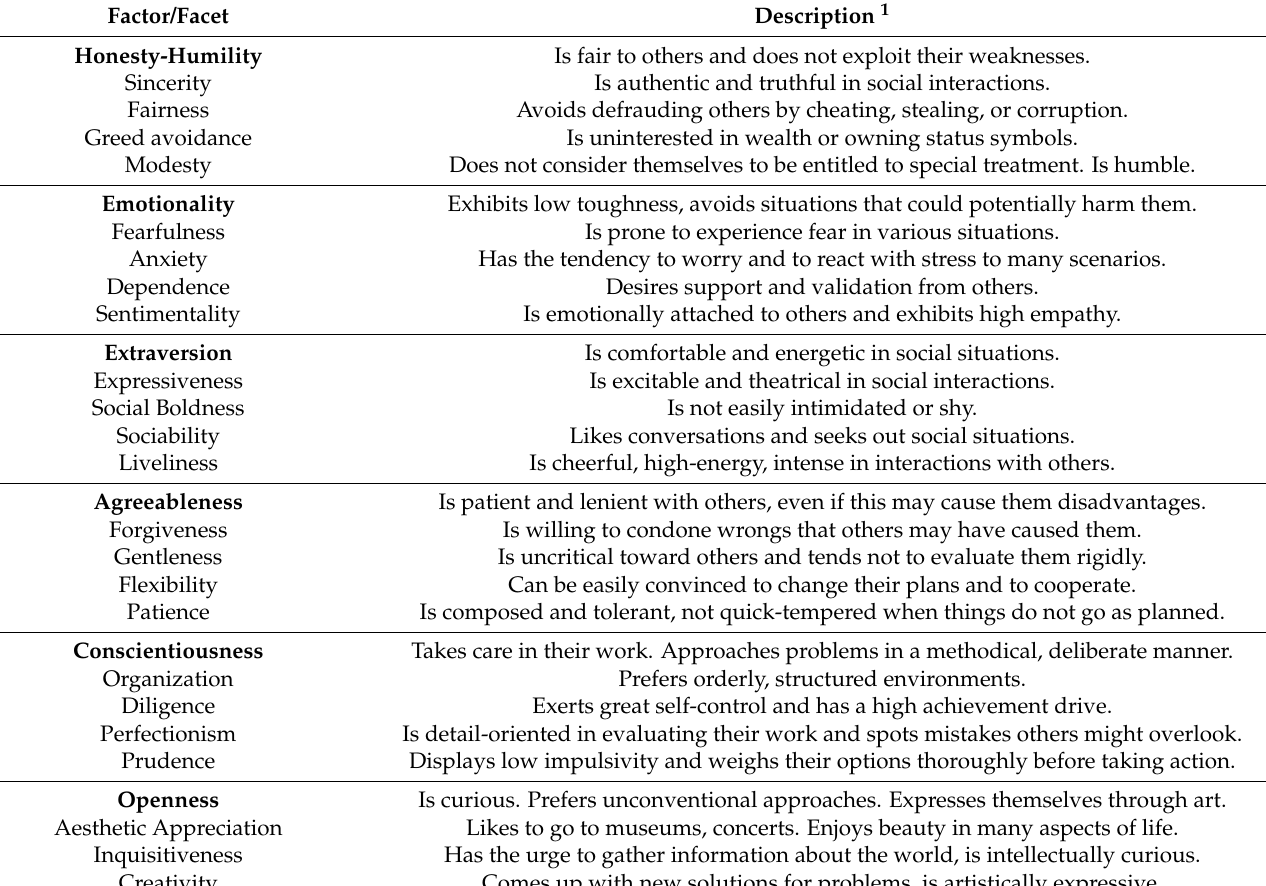
Table 1. Description of HEXACO factors and corresponding facets.